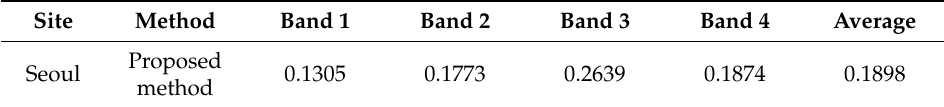
Figure 12. The experimental images for the additional dataset: ( a ) subject image acquired on 23 February 2017, ( b ) reference image acquired on 09 October 2015, and ( c ) normalization result of the proposed method. Table 5. NRMSE of the proposed method for the additional dataset.